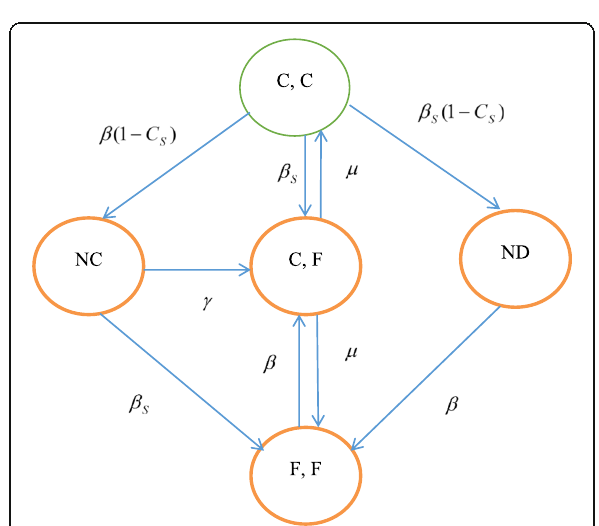
Fig. 1 State Transition Diagram of